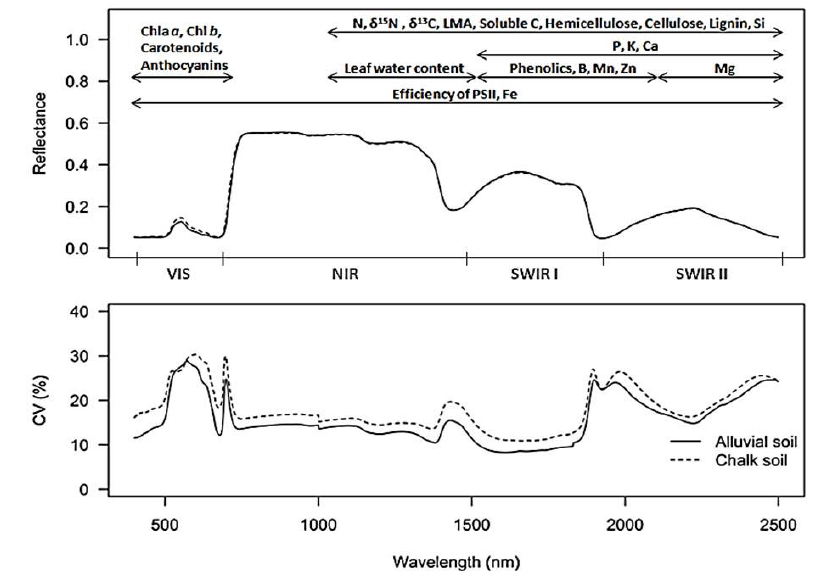
Figure 3. Spectral reflectance and percentage coefficient of variation (CV) of reflectance of six generalists species for alluvial and chalk soils. The spectral regions for each trait were selected based on the model that minimised